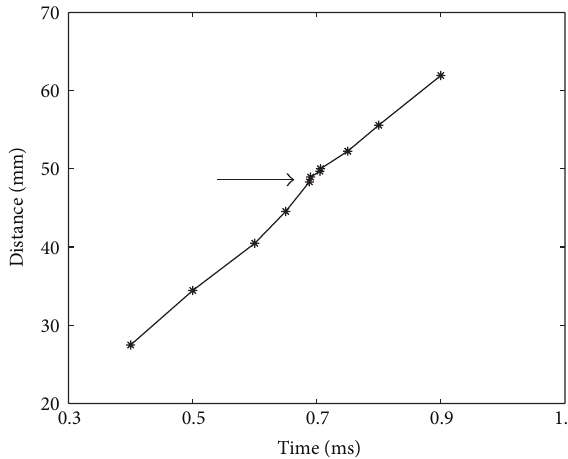
Figure 1: The shear deformation as a function of the distance between the excitation source and the measured site. Figure 2: Shear wave front propagation. Perturbation indicated by the arrow was when the wave front passed over the defect